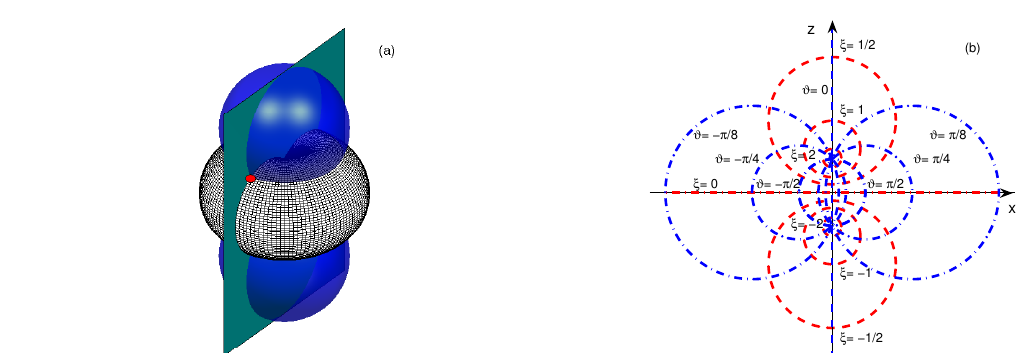
Figure 2. Schematic illustration of bi-spherical coordinates. ( a ) A surface, on which the bi-spherical coordinate ξ is constant, represents a sphere of a radius a / | sinh ξ | with center at ( z = a coth ξ 0 , x = y = 0). An orthogonal surface, on which the bi-spherical coordinate ϑ is constant, is formed by the circular arc with center ( x = a cot ϑ , z = 0) and radius a / | sin ϑ | rotating around the axis 0z. The coordinate α is the azimuthal angle about the z axis. ( b ) Circles of constant ξ and ϑ in the ( x ; z ) plane are shown in panel ( b ).